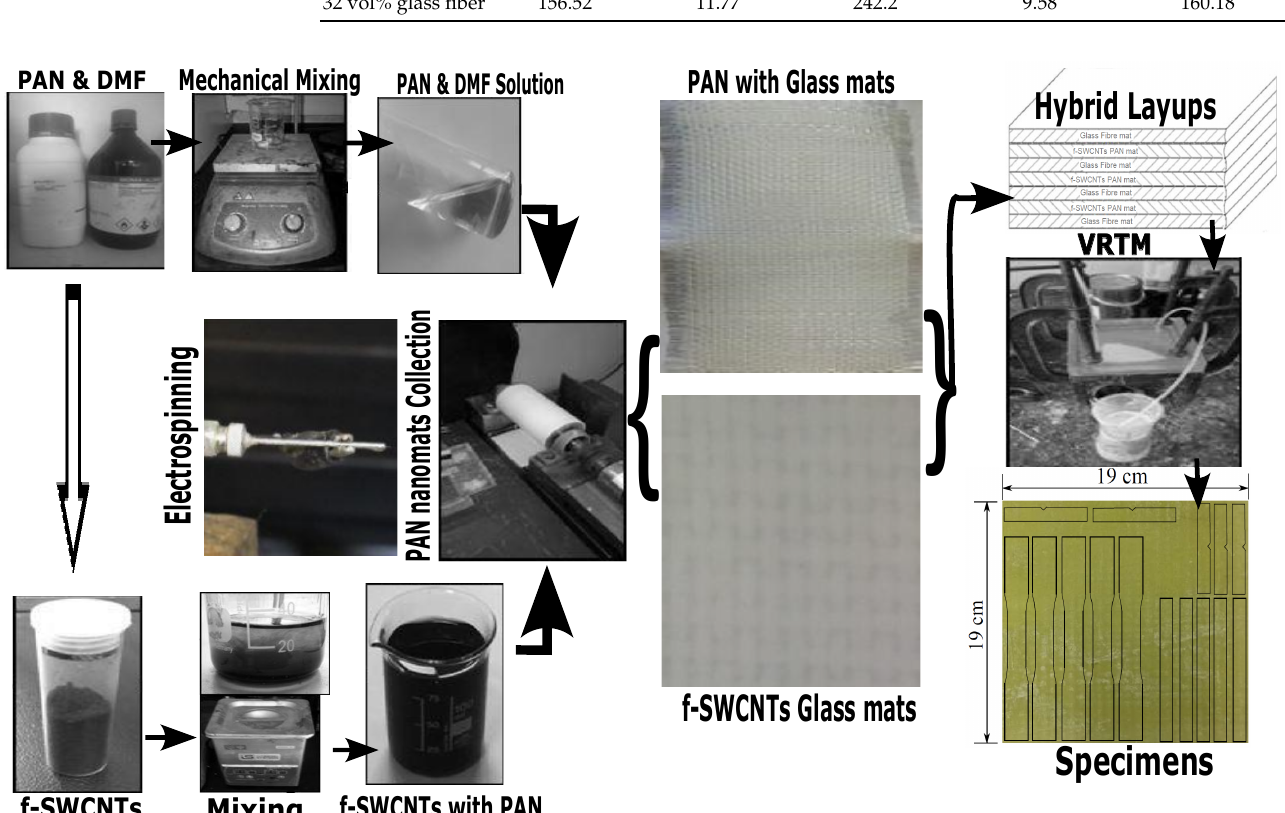
Figure 5. Fabrication process of glass fiber hybrid composites